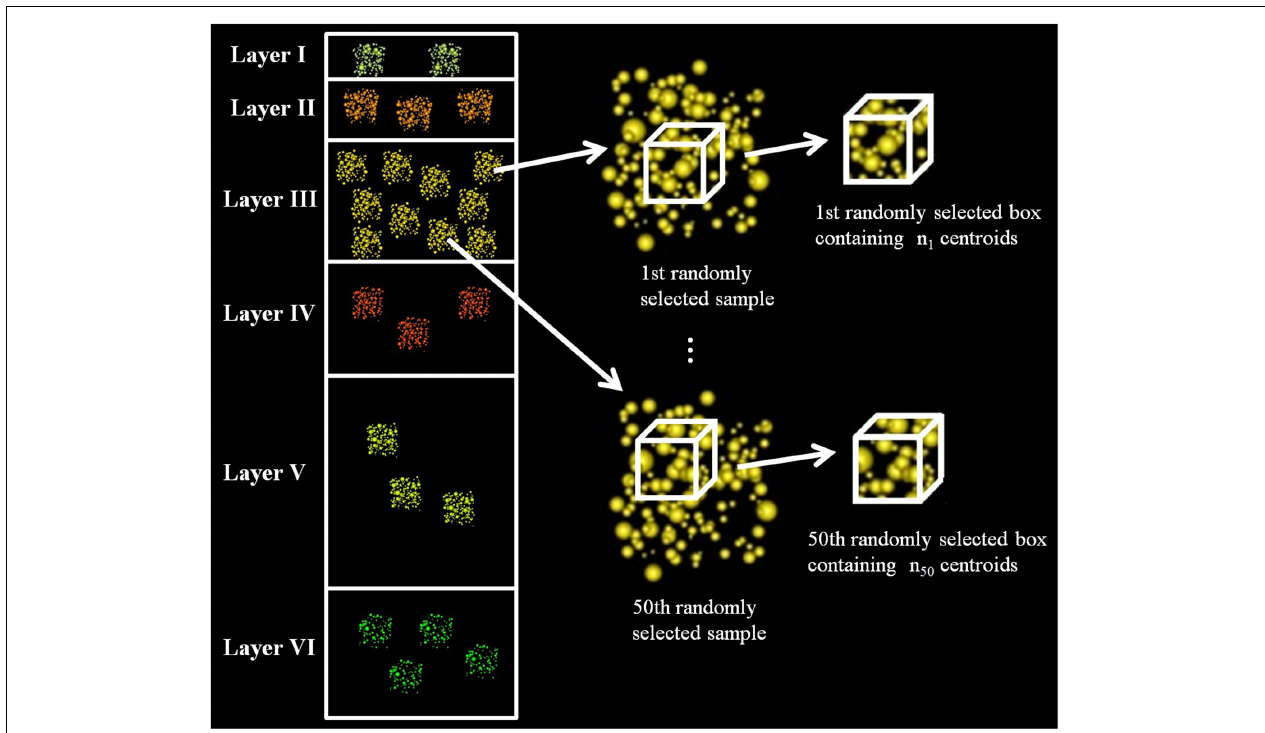
FIGURE 1 | Diagram of data extraction to analyze whether the synaptic densities of cortical layers are significantly different. The figure shows how we randomly selected a sample from layer III, then we extracted, also randomly, a box inside this sample and counted the number of synaptic